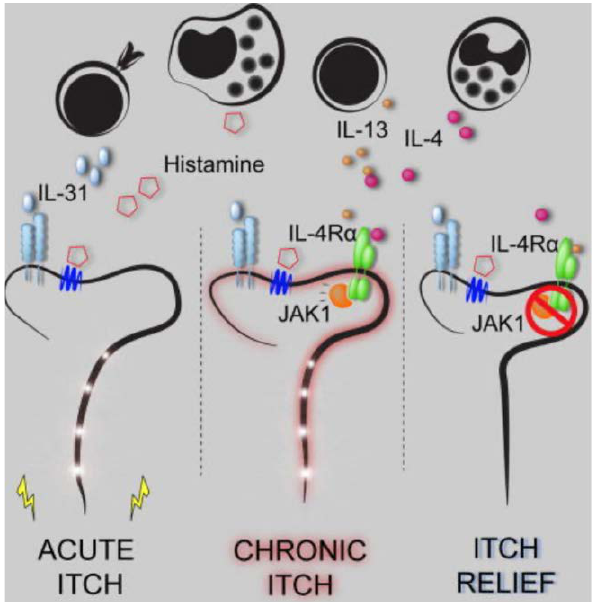
Figure 3. Acute and Chronic itch: IL-31 mediates acute itching via IL-31RA. The activation of IL- 4Rα mediates chronic itch via JAK1. The inhibition of JAK1 ameliorates the symptoms (Copyright per- mission to reproduced this Figure has been obtained from